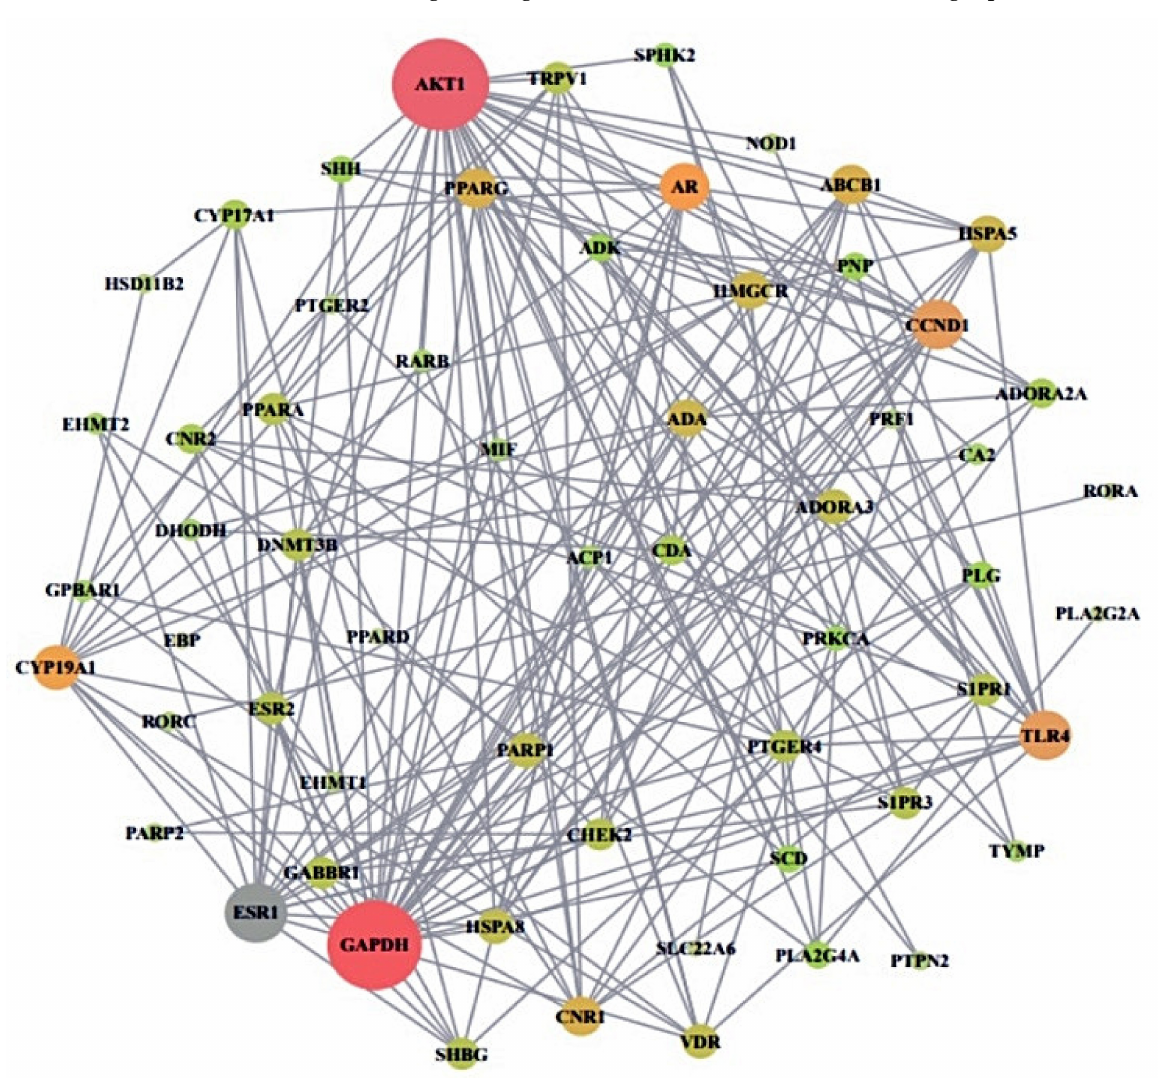
Figure 4. PPI networks of final overlapping 60 target proteins (60 nodes and 199 edges). Nodes: The number of networking proteins; Edges: Interactions between protein(s) and